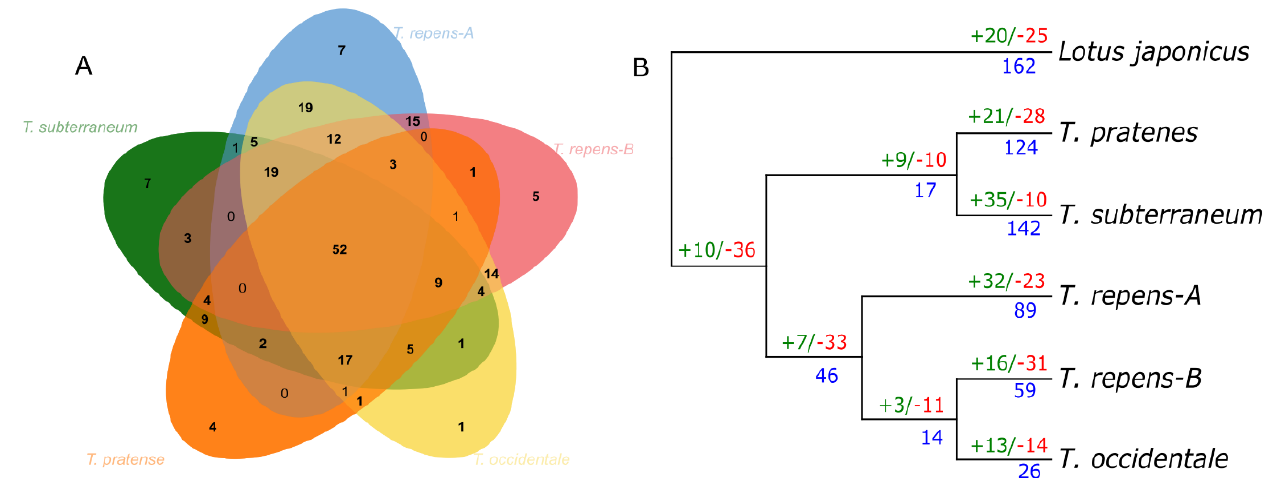
Figure 4. The number of gene gain and gene loss analysis. ( A ) The ortho Venn diagram depicts the shared NLR genes among species of Trifolium . ( B ) The red color code represents the gene loss, green indicates gene gain and blue denotes gene duplication.